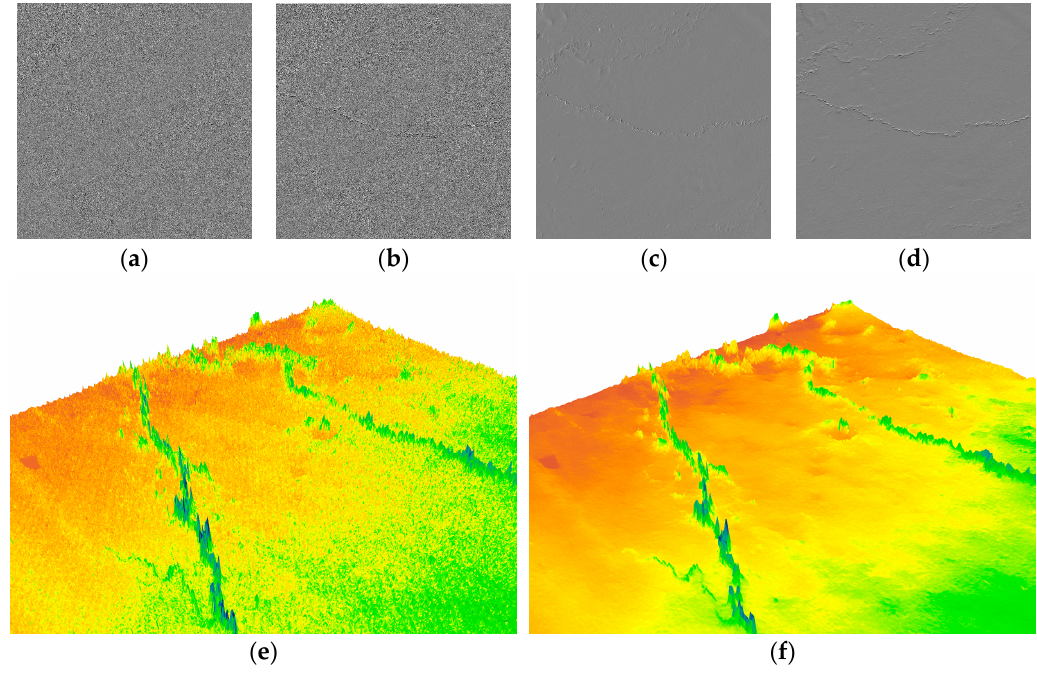
Figure 16. The gradient changes and the local 3Dmodel of the data. ( a ) Horizontal gradient of area S35E144, ( b ) vertical gradient of area S35E144, ( c ) horizontal gradient of area S35E144 using the proposed method, ( d ) vertical gradient of area S35E144 area using the proposed method, ( e ) local enlargement of area S35E144, ( f ) local enlargement of area S35E144 area after removing the error using LRGS.